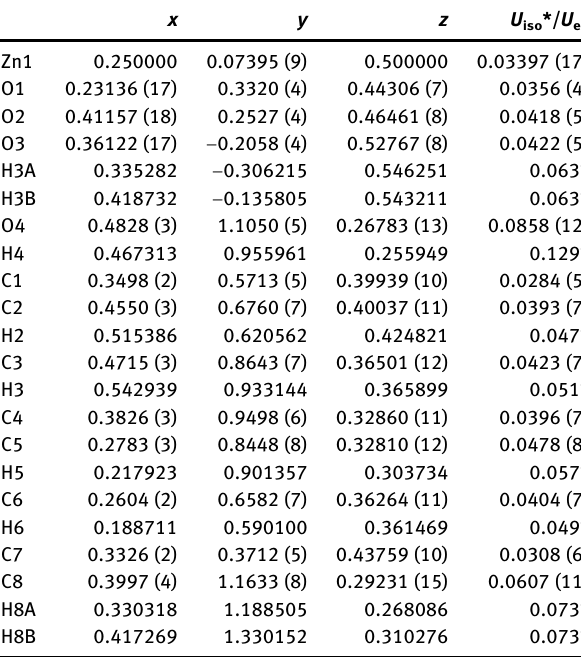
Table  : Fractional atomic coordinates and isotropic or equivalent isotropic displacement parameters (Å 